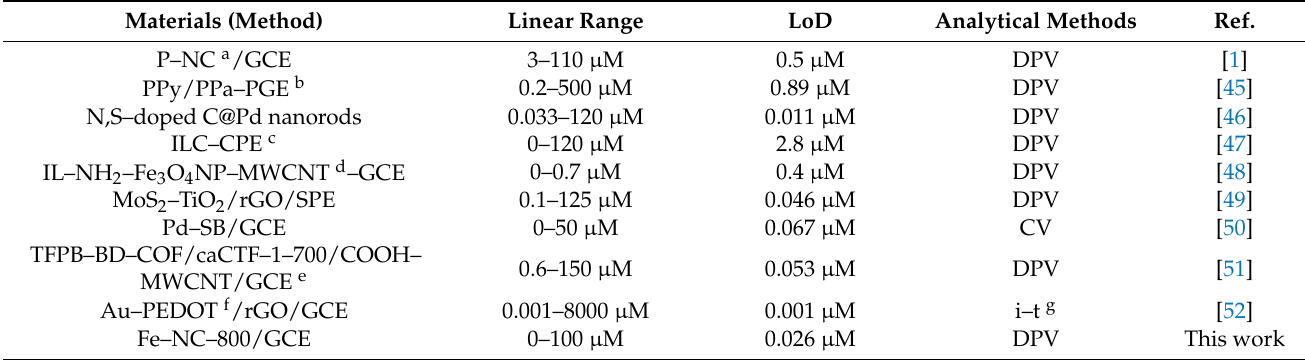
Table 1. Comparison of LOD of various AC electrochemical